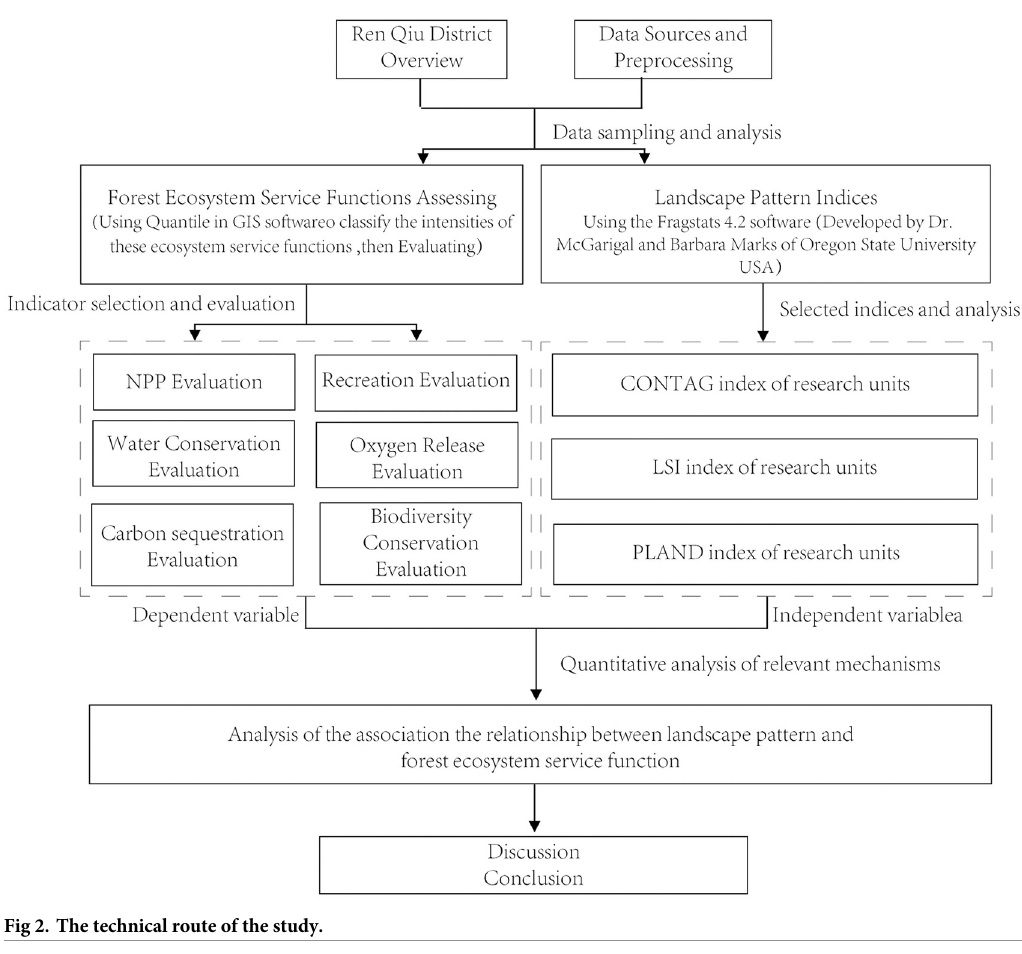
Fig 2. The technical route of the